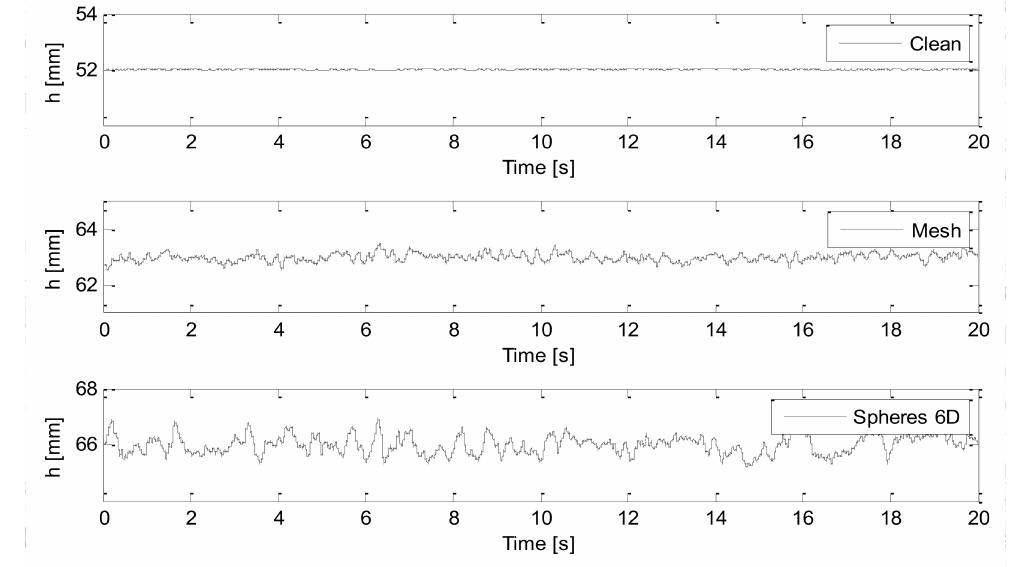
Figure 3. Examples of the water level fluctuations recorded on wave probe 1 (h) measured for 20 s in the clean pipe at V = 0.24 m/s and h = 52 mm, pipe with the mesh at V = 0.21 m/s and h = 63 mm, and pipe with 6D spheres arrangement at V = 0.20 m/s and h = 66 mm.